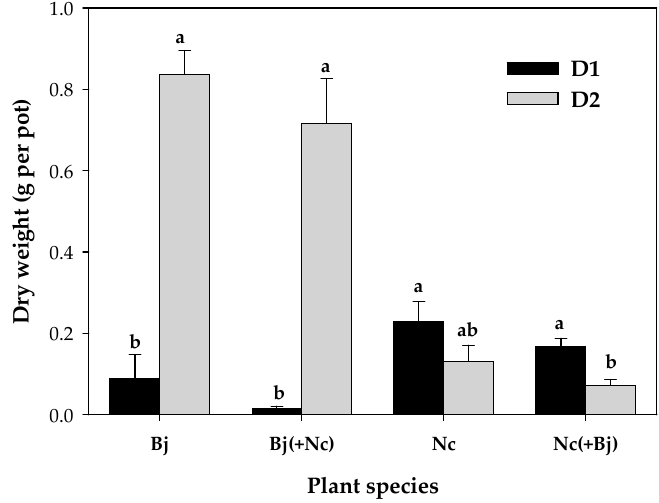
Figure 1. Plant dry weight in the different soils and types of cultivation (g DW pot − 1 ± standard error). For each species, bars marked with different letters indicate significant differences at p < 0.05, according to Tukey’s test. Bj = B. juncea ; Nc = N. caerulescens .